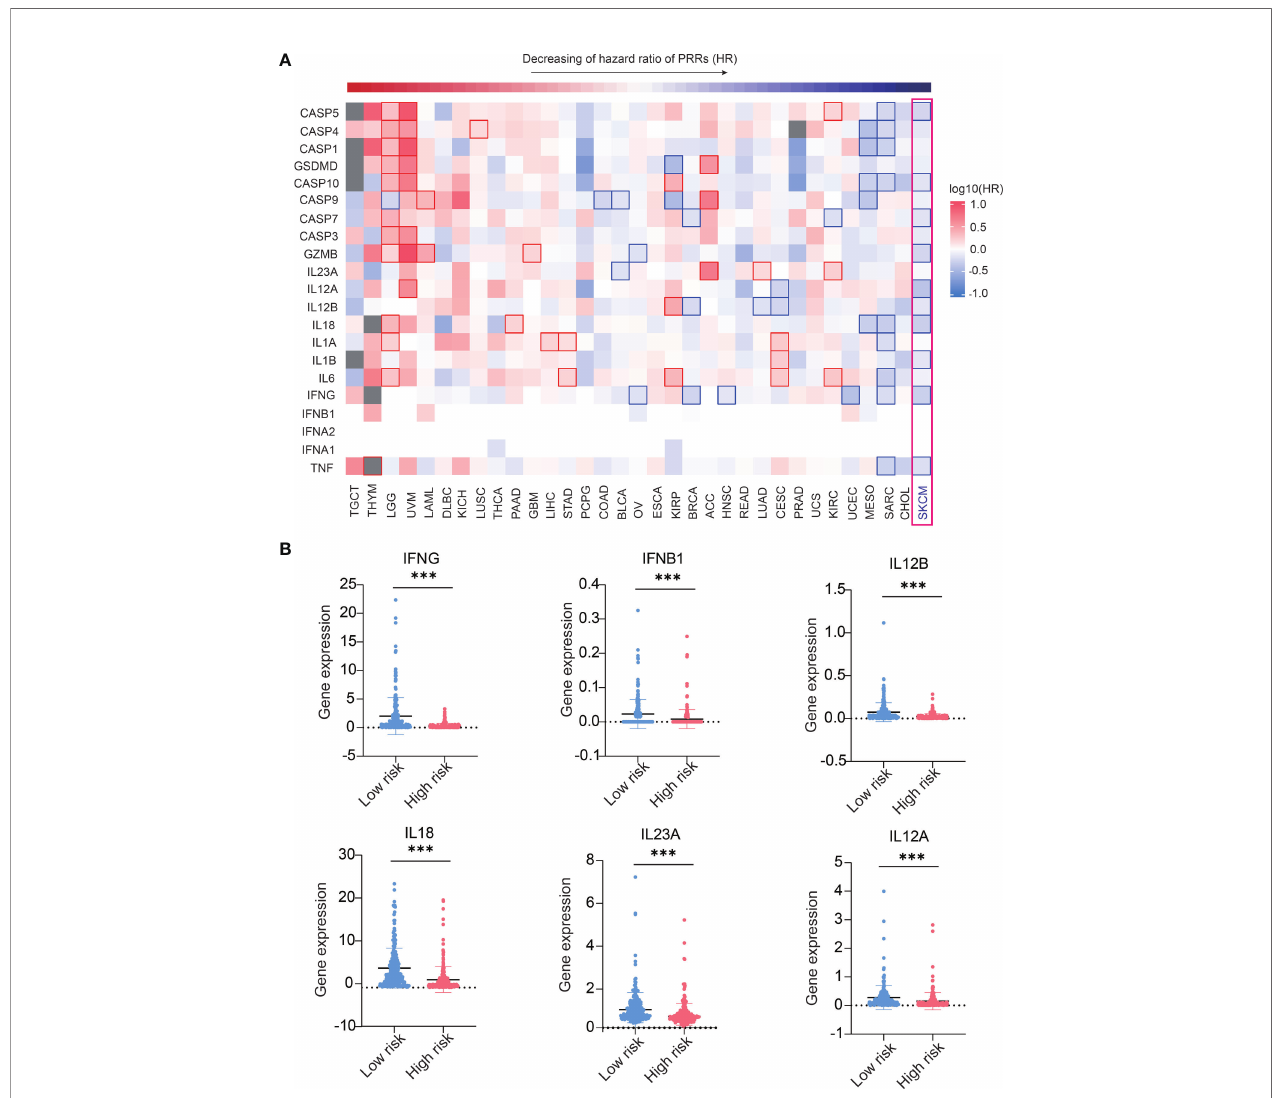
FIGURE 5 | Expression of immune effector genes play a positive role in SKCM prognosis. (A) Pan-cancer prognosis analysis shows the expression of PRR-driven effector molecules highly correlated to SKCM prognosis (33 tumor types, 9502 samples). (B) 6 in fl ammatory cytokines express higher in low risk SKCM patients (n (low risk)=234, n(high risk)=234, “ *** ” means